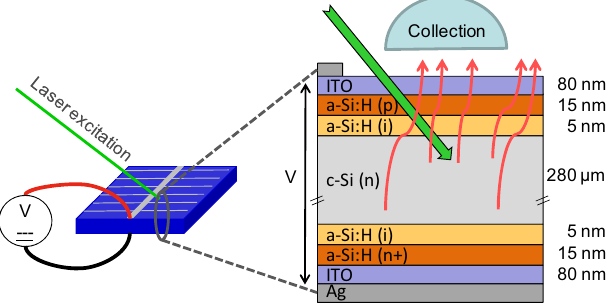
Fig. 1. Schematic of a HJ solar cell in our experimental con- figuration, showing the DC-supply, as well as the optical exci- tation supplied by a green